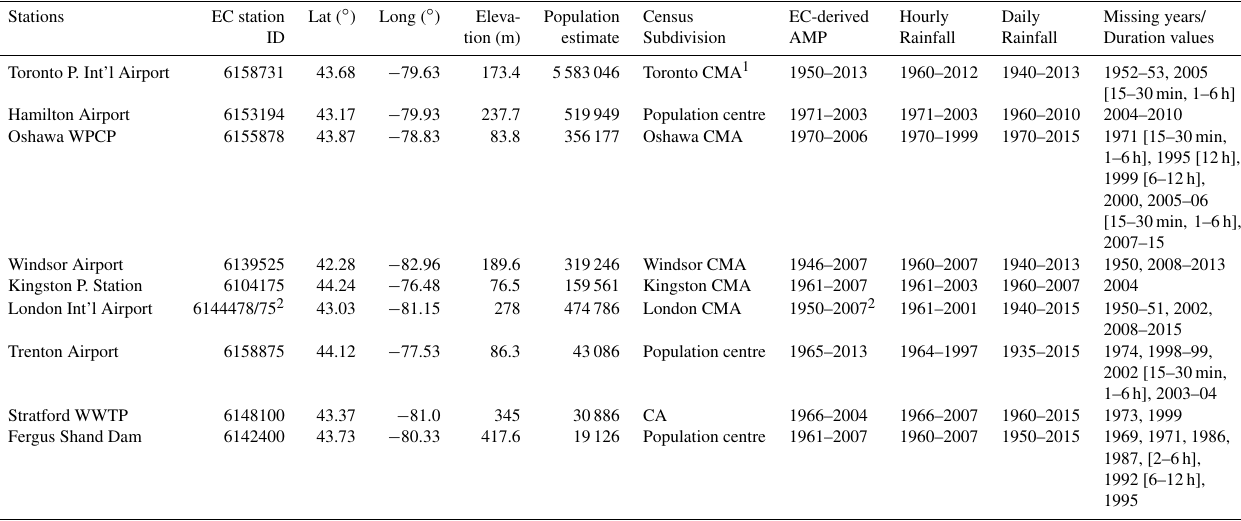
Table 1. Selected station locations, population distribution, and hourly and daily data availability. Stations EC station Lat ( ◦ ) Long ( ◦ ) Eleva- Population Census EC-derived Hourly Daily Missing years/ ID tion (m) estimate Subdivision AMP Rainfall Rainfall Duration values Toronto P. Int’l Airport 6158731